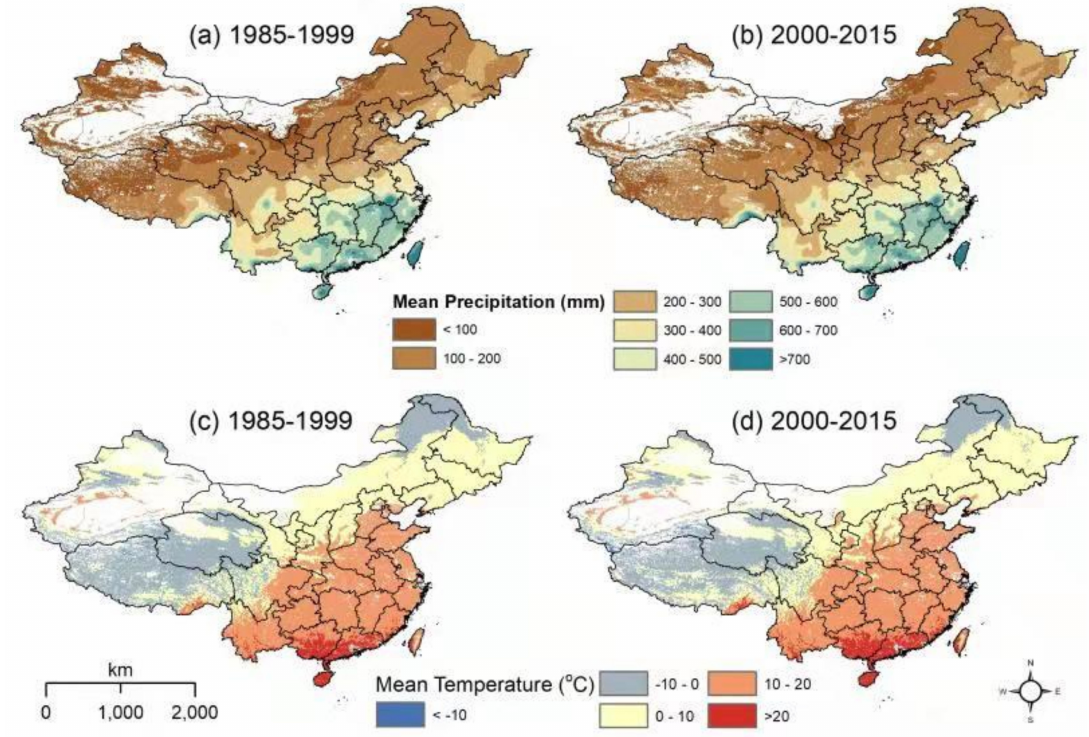
Figure 1. Climate factors used for this study: ( a , b ) mean precipitation base and restoration periods; ( c , d ) mean temperature for base and restoration